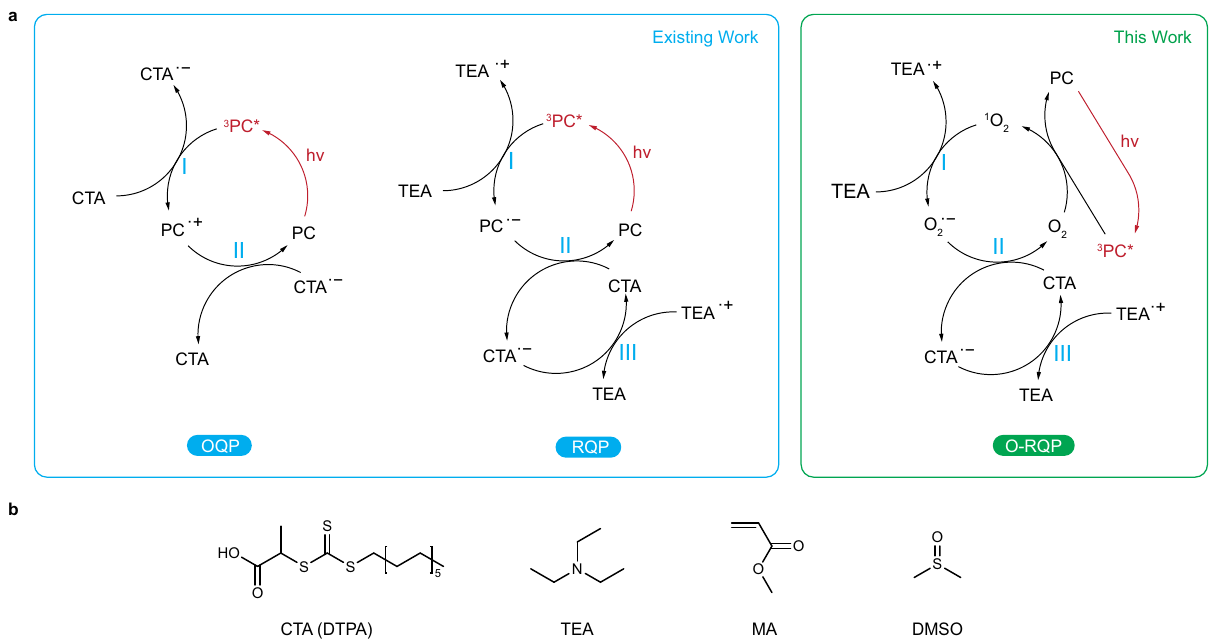
Fig. 1 Model PET-RAFT polymerisation and mechanisms. a Catalytic cycles for the model PET-RAFT polymerisation via OQP (left), RQP (middle) and O- RQP (right). b Molecular structures for the chain-transfer agent, 2-(dodecylthiocarbonothioylthio)propionic acid (CTA, DTPA), co-catalyst, triethylamine (TEA), monomer, methyl acrylate (MA) and solvent dimethyl sulfoxide (DMSO) for the model PET-RAFT polymerisation. OQP oxidative quenching pathway, RQP reductive quenching pathway, O-RQP oxygen-mediated reductive quenching